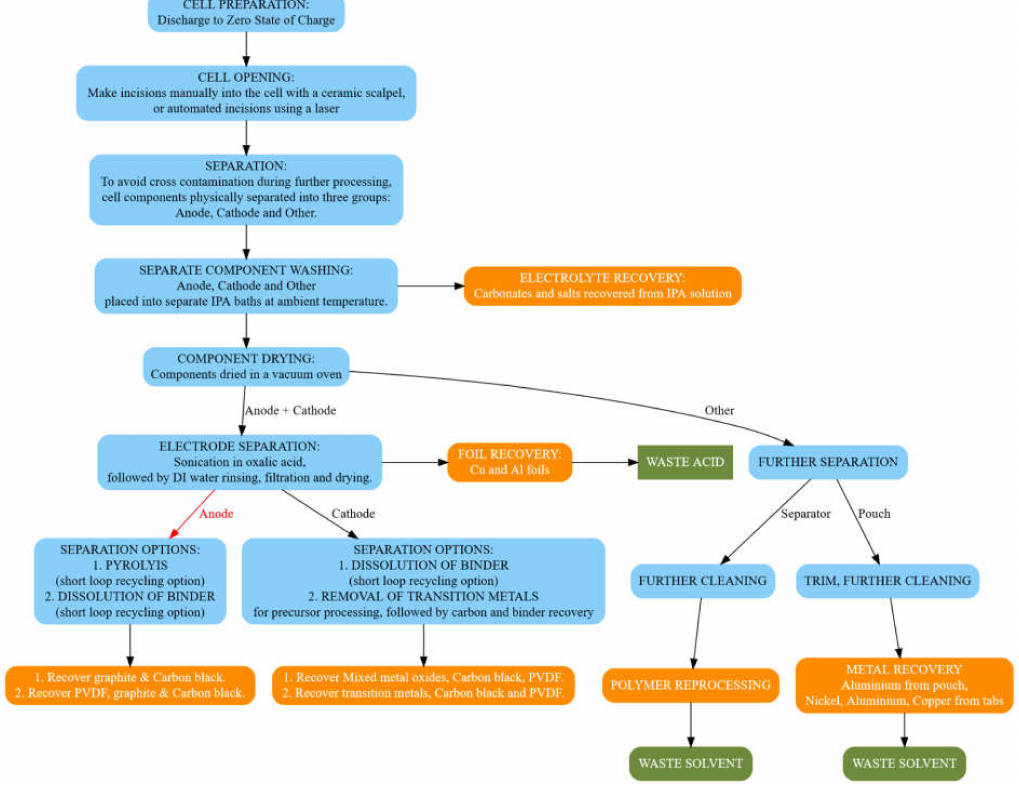
Figure 2. Schematic diagram describing our procedure for the disassembly of a Li-ion battery. Steps marked in blue are our procedure steps for each stage of the cell teardown. Boxes marked in orange represent the recovered materials. Boxes marked in green represent waste